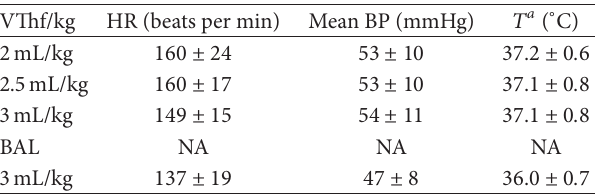
Table 1: Physiological variables at different VThf before and after surfactant depletion by